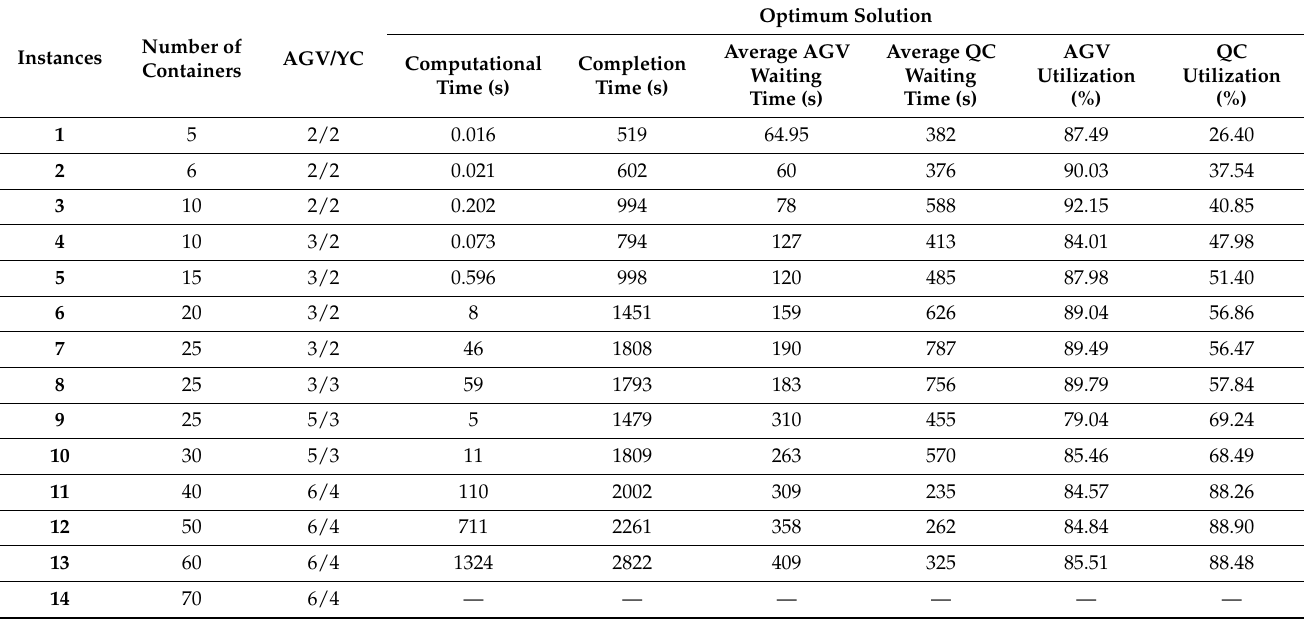
Table 1. Computational results for dual-trolley QCs with a buffer capacity equal to